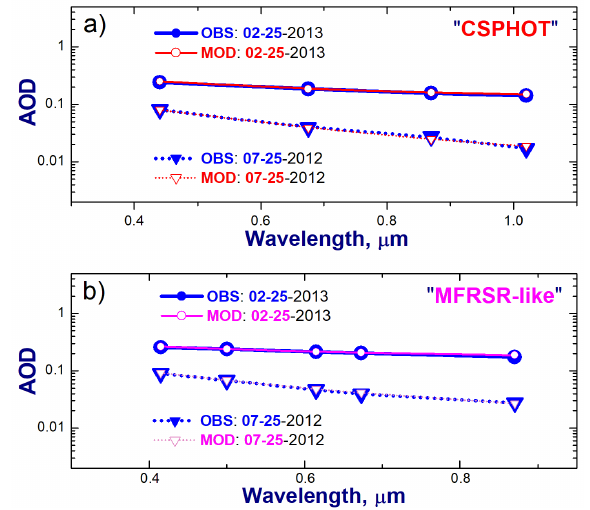
Figure 3. Examples of the measured (symbol “obs”) and calculated (symbol “mod”) spectrally resolved AODs for summer (25 July 2012; dotted lines) and winter (25 February 2013; solid lines) days. The calculated AODs represent results from two retrieval schemes (Section 2), where the model SDs are estimated from the CSPHOT AODs measured at four (0.44, 0.675, 0.87, 1.02 µm) wavelengths ( a ) and from “MFRSR-like” AODs obtained at five (0.415, 0.5, 0.615, 0.675, 0.87 µm) wavelengths ( b ), respectively.